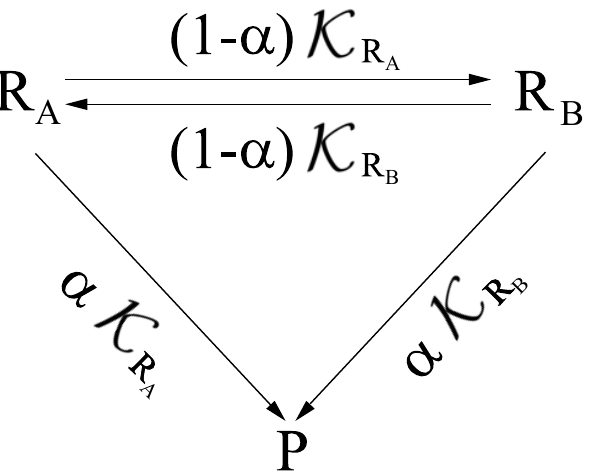
Figure A2. Reaction scheme for the complete R → P transition as occurring through all the TR reactions (see